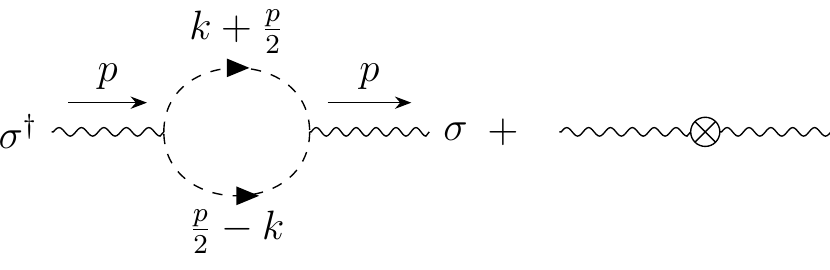
Figure 7 . Wavy line represents σ propagator and the dashed line represents φ I